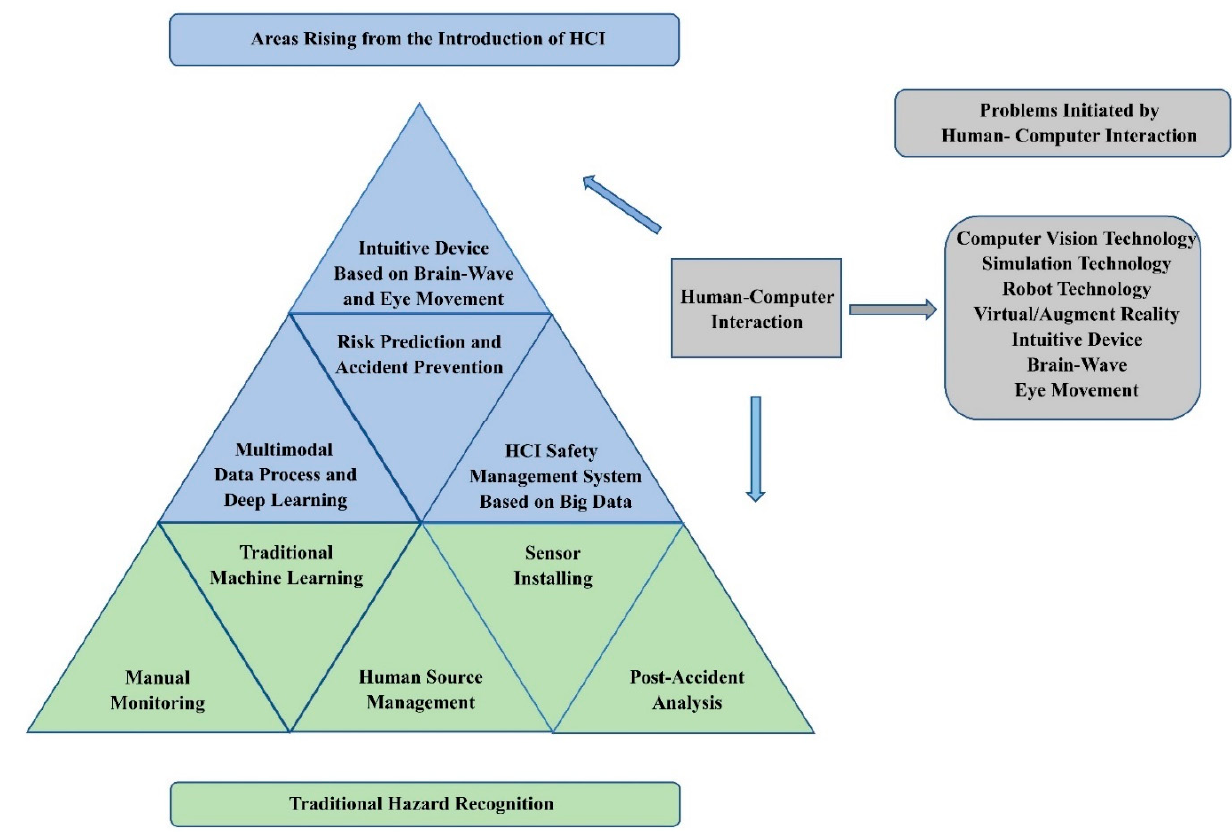
Figure 11. Interaction of hazard recognition and HCI.